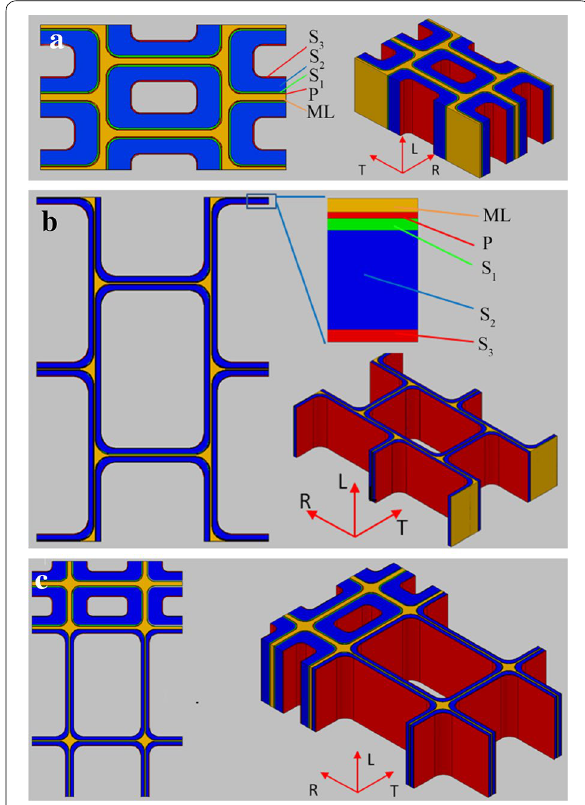
Fig. 3 LW, EW, or EW/LW combination hierarchical models. a LW; b EW; c EW/LW combination